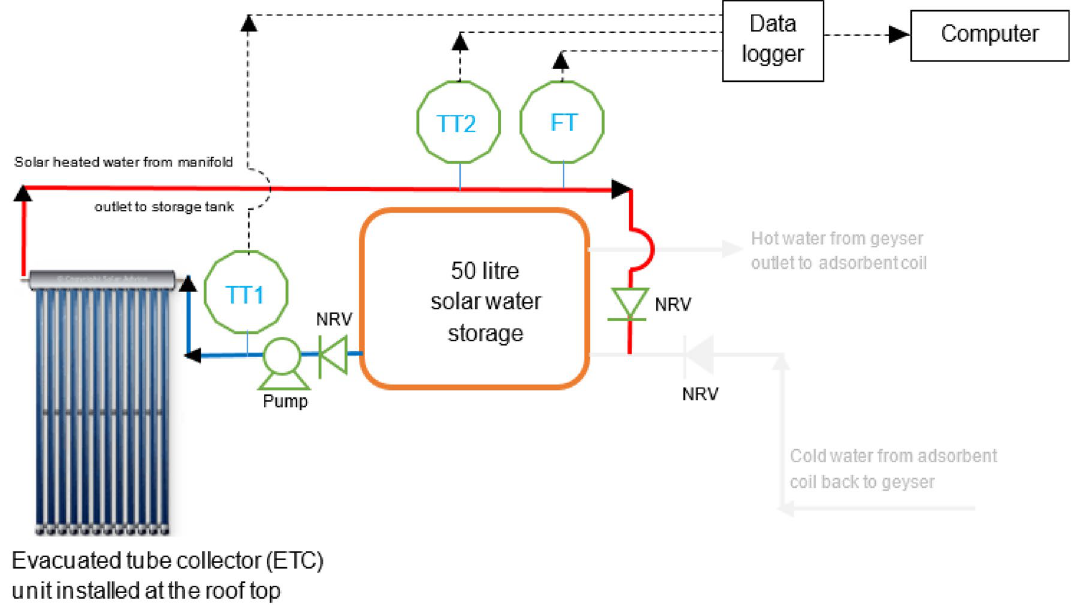
Fig. 2 Pipe and instrumentation diagram of the solar collector array testing